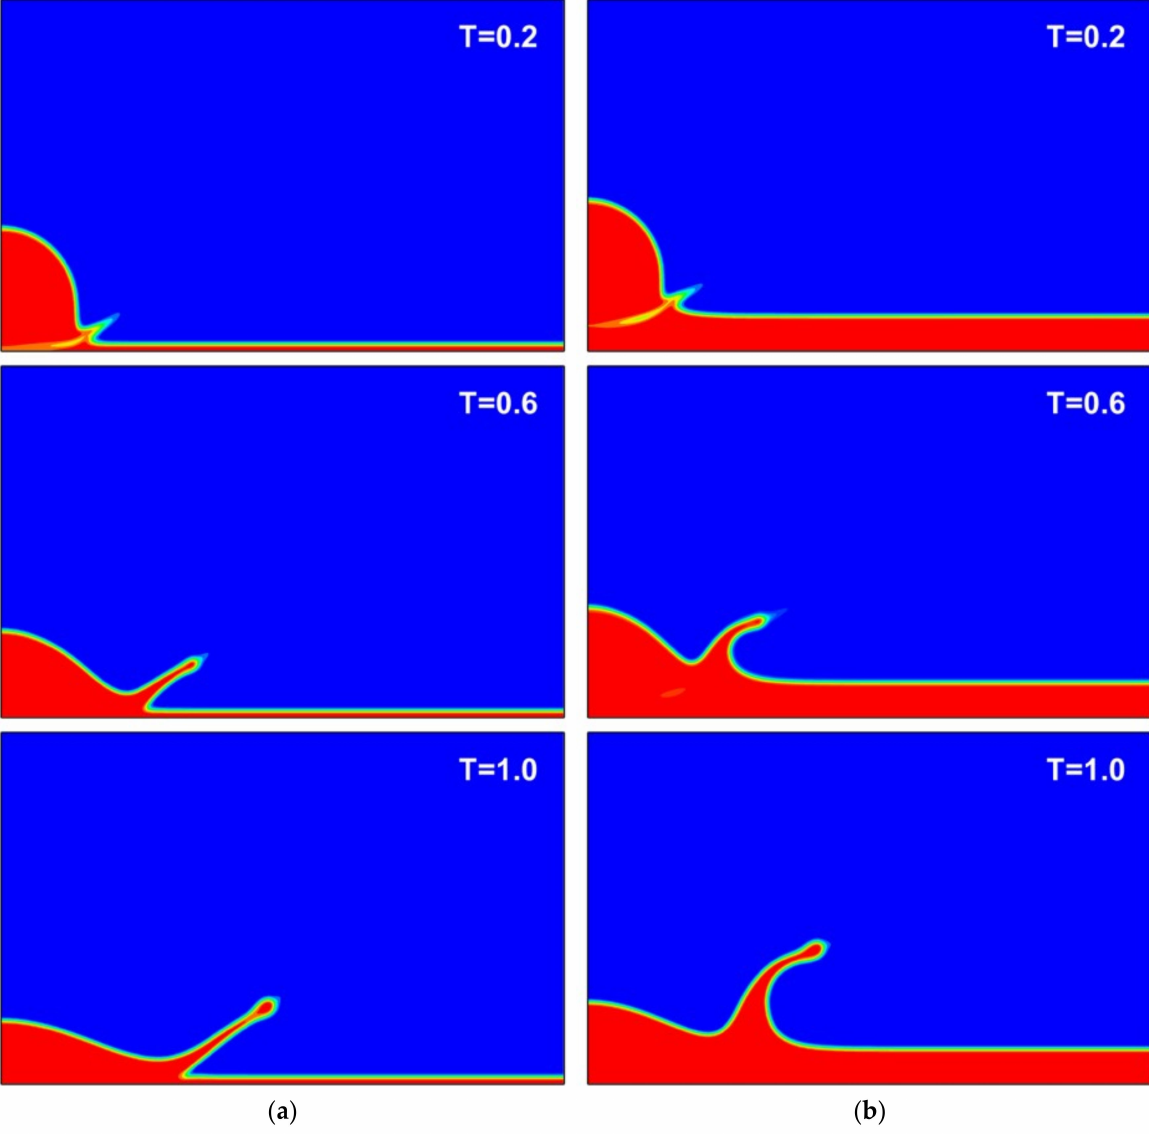
Figure 23. Development of the interface with Re = 800 and We = 150 with the present method: ( a ) H = 5, ( b ) H =